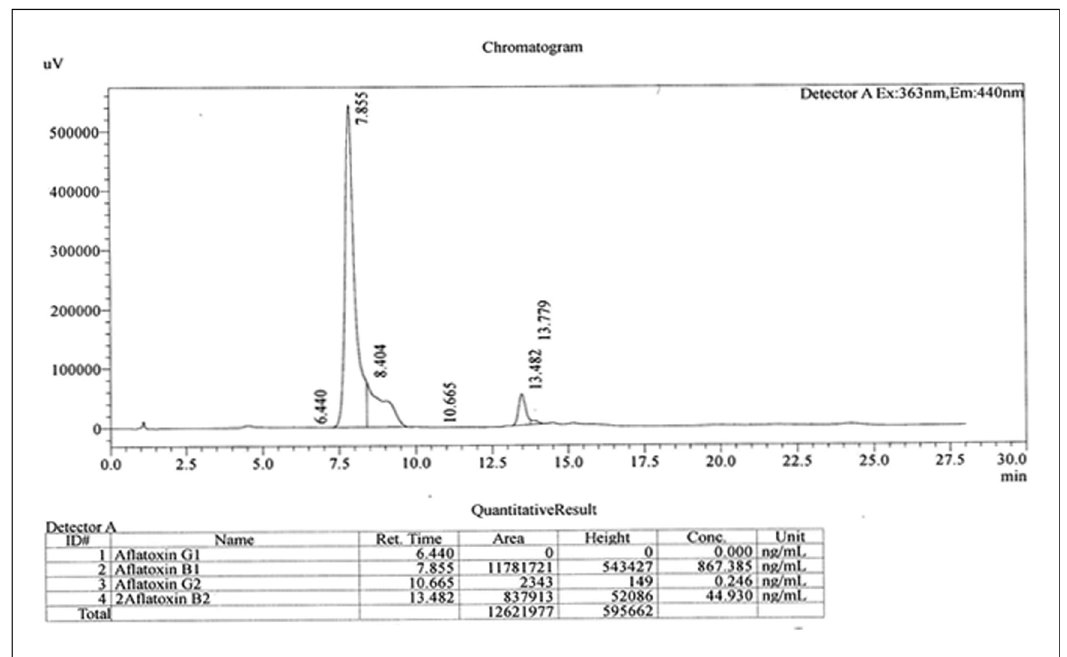
Figure 4: Chromatogram of a maize sample from Baringo County observed in